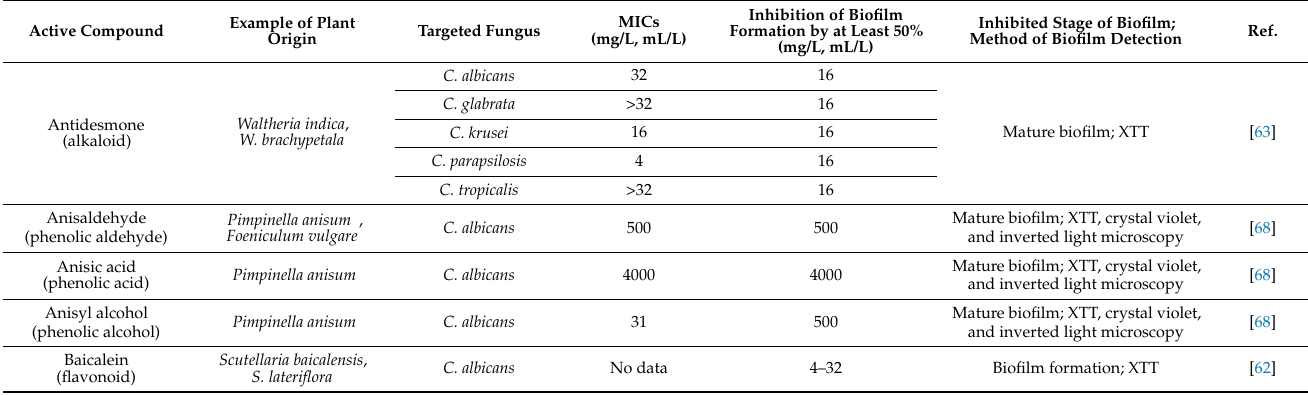
Table 2. Antifungal and antibiofilm activity of plant